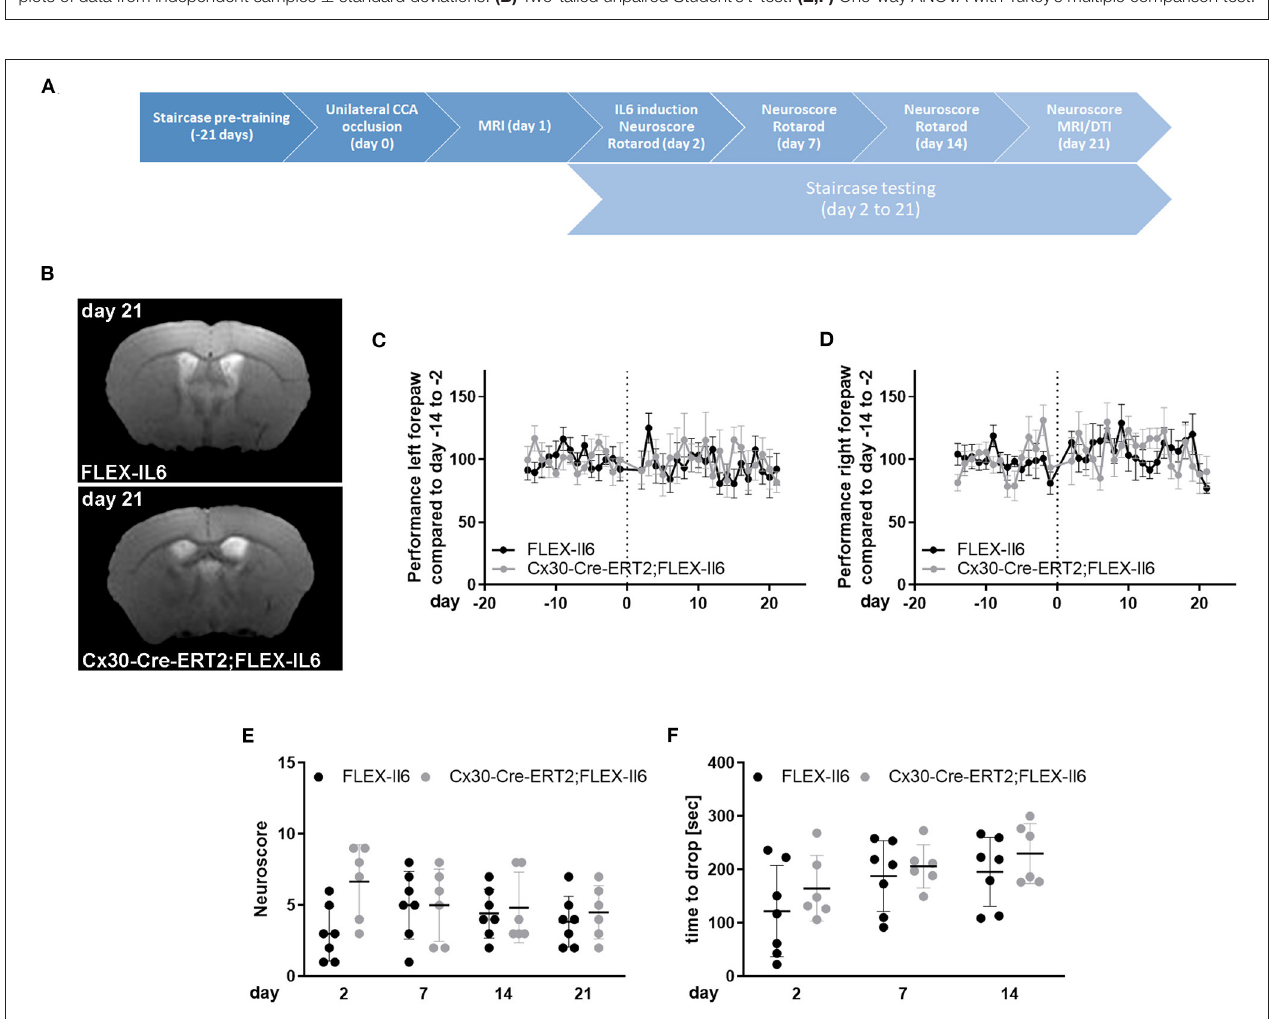
FIGURE 1 | dot plots. FLEX-IL6 ( n = 4) mice receiving 1mg tamoxifen for 3 days and wild-type C57BL/6N ( n = 4) served as negative controls. Immunoblot IL-6 intensities were normalized to GAPDH intensity ( ∼ 37 kD). There is a moderate increase of IL-6 in Cx30-Cre-ERT2;FLEX-IL6 mice ( n = 4) receiving a single tamoxifen dose compared to the control group ( ∼ 25 kD, arrowhead closed). Mice that received three doses of tamoxifen ( n = 6) showed increased but significantly lower brain IL-6 than after a single dose. (F) IL-6 serum levels were determined using ELISA measurement of mice with astrocytic IL-6 expression (Cx30-Cre-ERT2;FLEX-IL6, n = 5), mice with endothelial IL-6 expression (VeCdh-Cre-ERT2; FLEX-IL6, n = 37), and Cre-negative controls ( n = 5). There was a marked increase in serum IL-6 upon endothelial expression. At the same time, IL-6 remained at baseline level comparable to Cre-negative controls upon astrocytic expression. Graphs show scatter dot